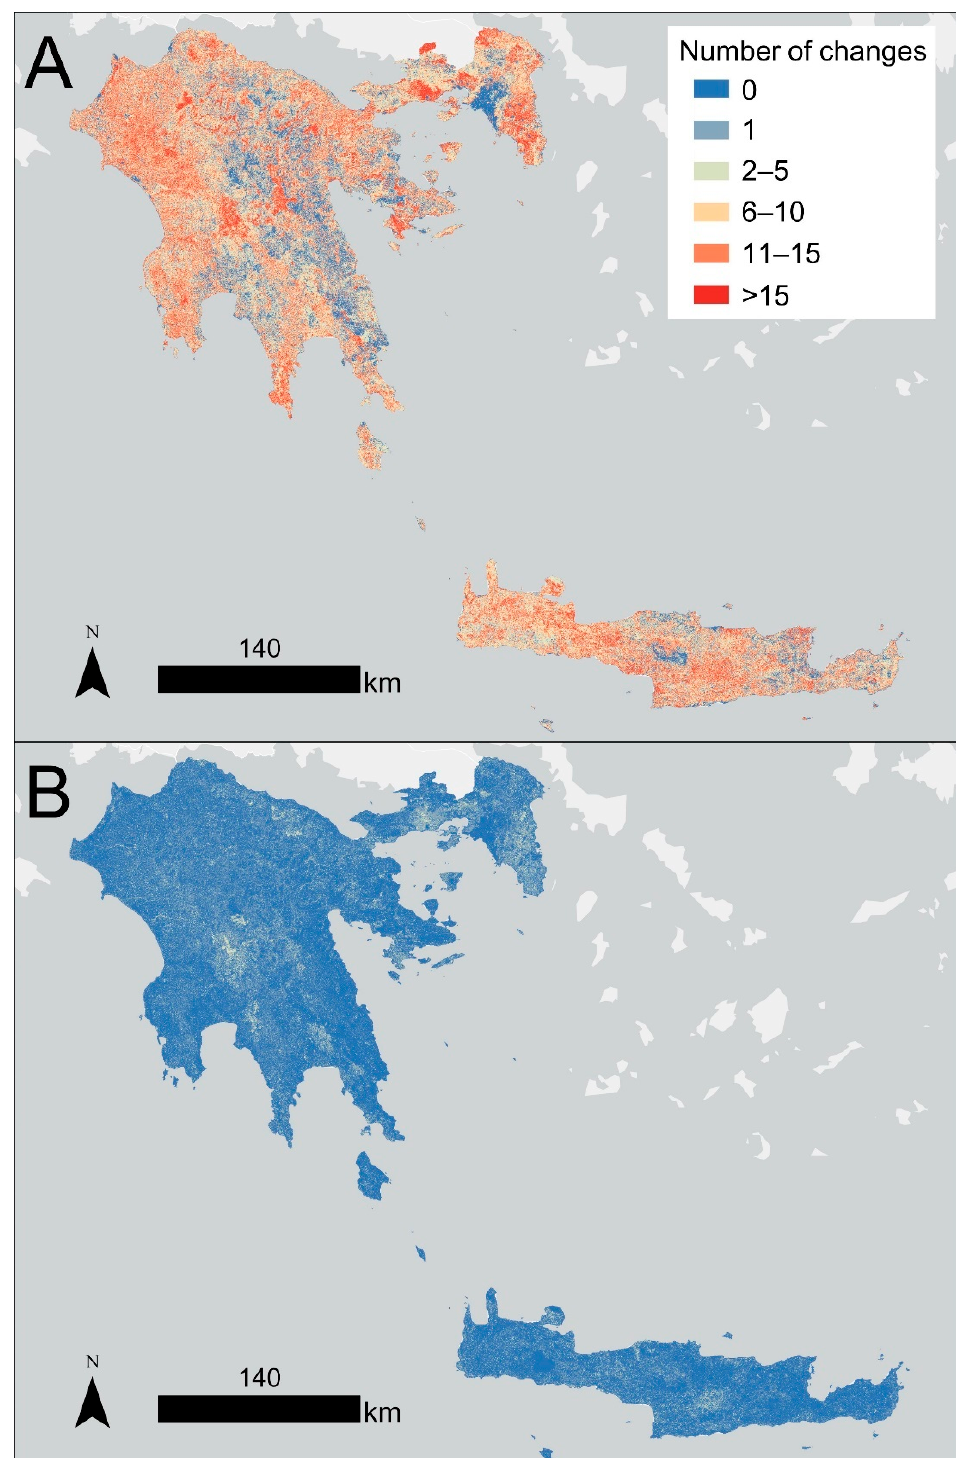
Figure 4. Number of landcover changes (i.e., the number of transitions from one landcover class to another) from 1986 to 2020 before ( A ) and after ( B ) time series HMM post-processing.